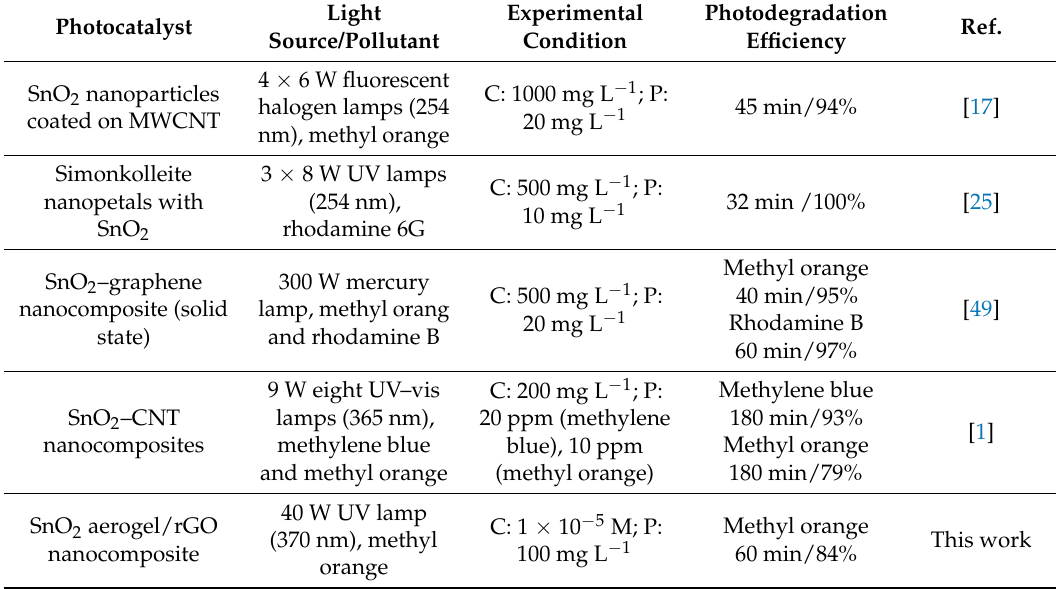
Table 3. Comparison of photocatalytic performance of SnO 2 aerogel/rGO nanocomposite photocatalyst in this work with previously reported composite